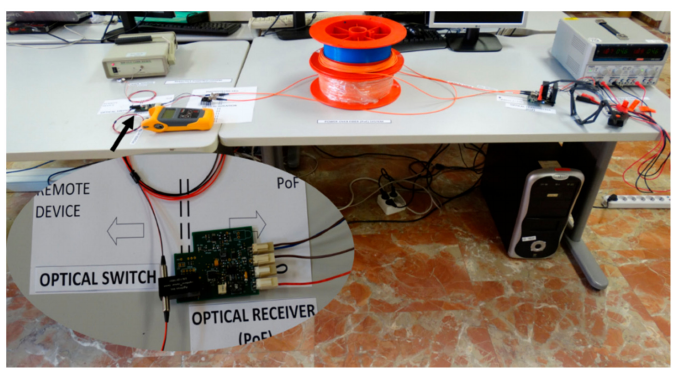
Figure 4. Picture of the 100-m-long Power over Fiber system at the laboratory. Inset: remote optically powered switch.